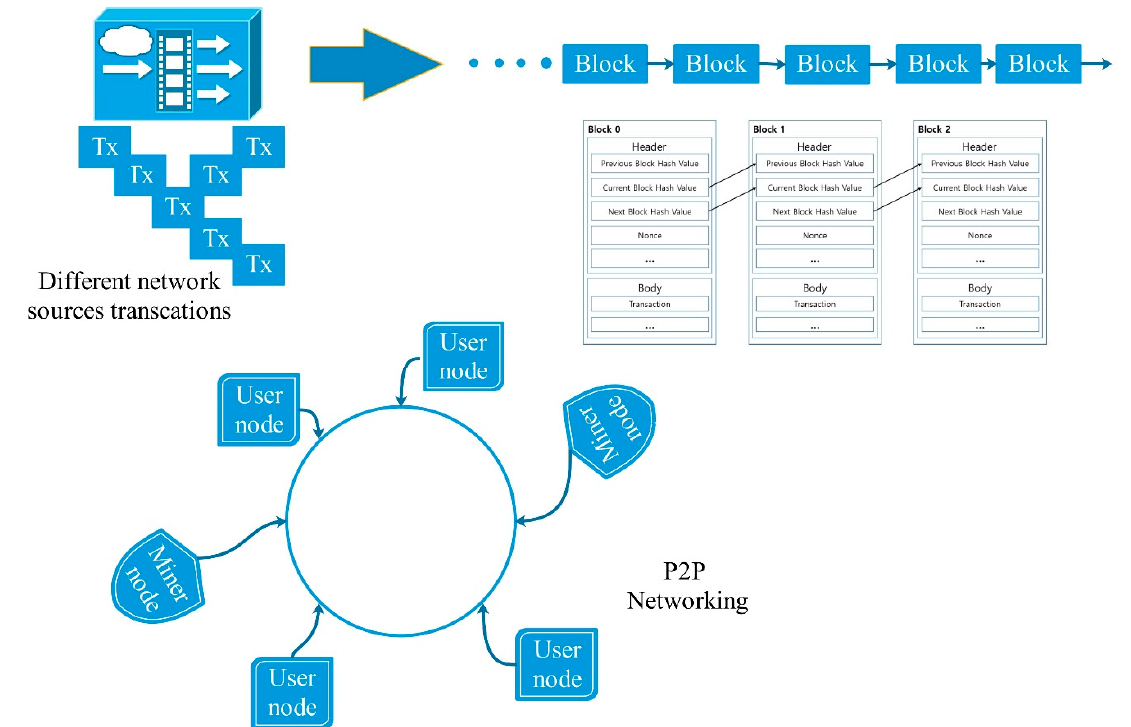
Figure 1. The overview of the blockchain structure.